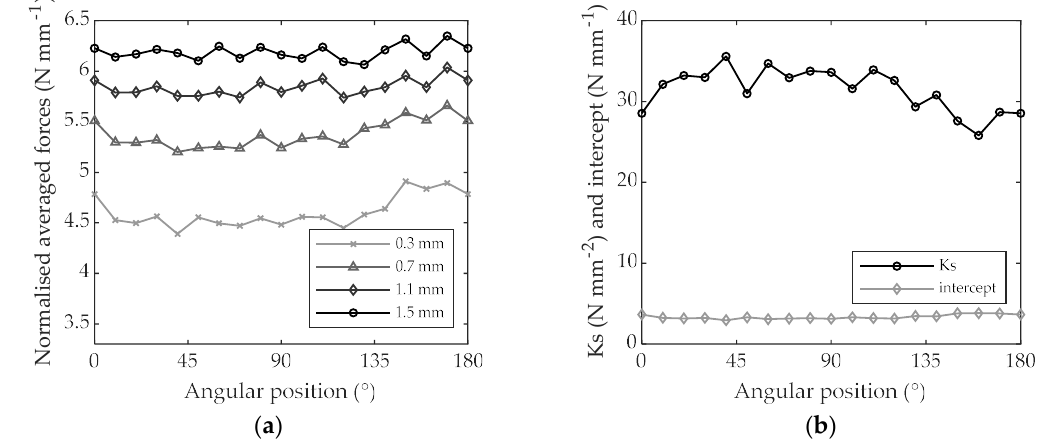
Figure 11. ( a ) Average cutting force referring to the cutting period versus angular position when machining MDF with 0.3, 0.7, 1.1 and 1.5 mm of depth of cut; ( b ) intercept and specific cutting coefficient gathered every 10° of angular position. Table 3. Average specific cutting coefficient ( 𝐾𝑠 ) and intercept values computed when machining MDF with the up-milling technique.